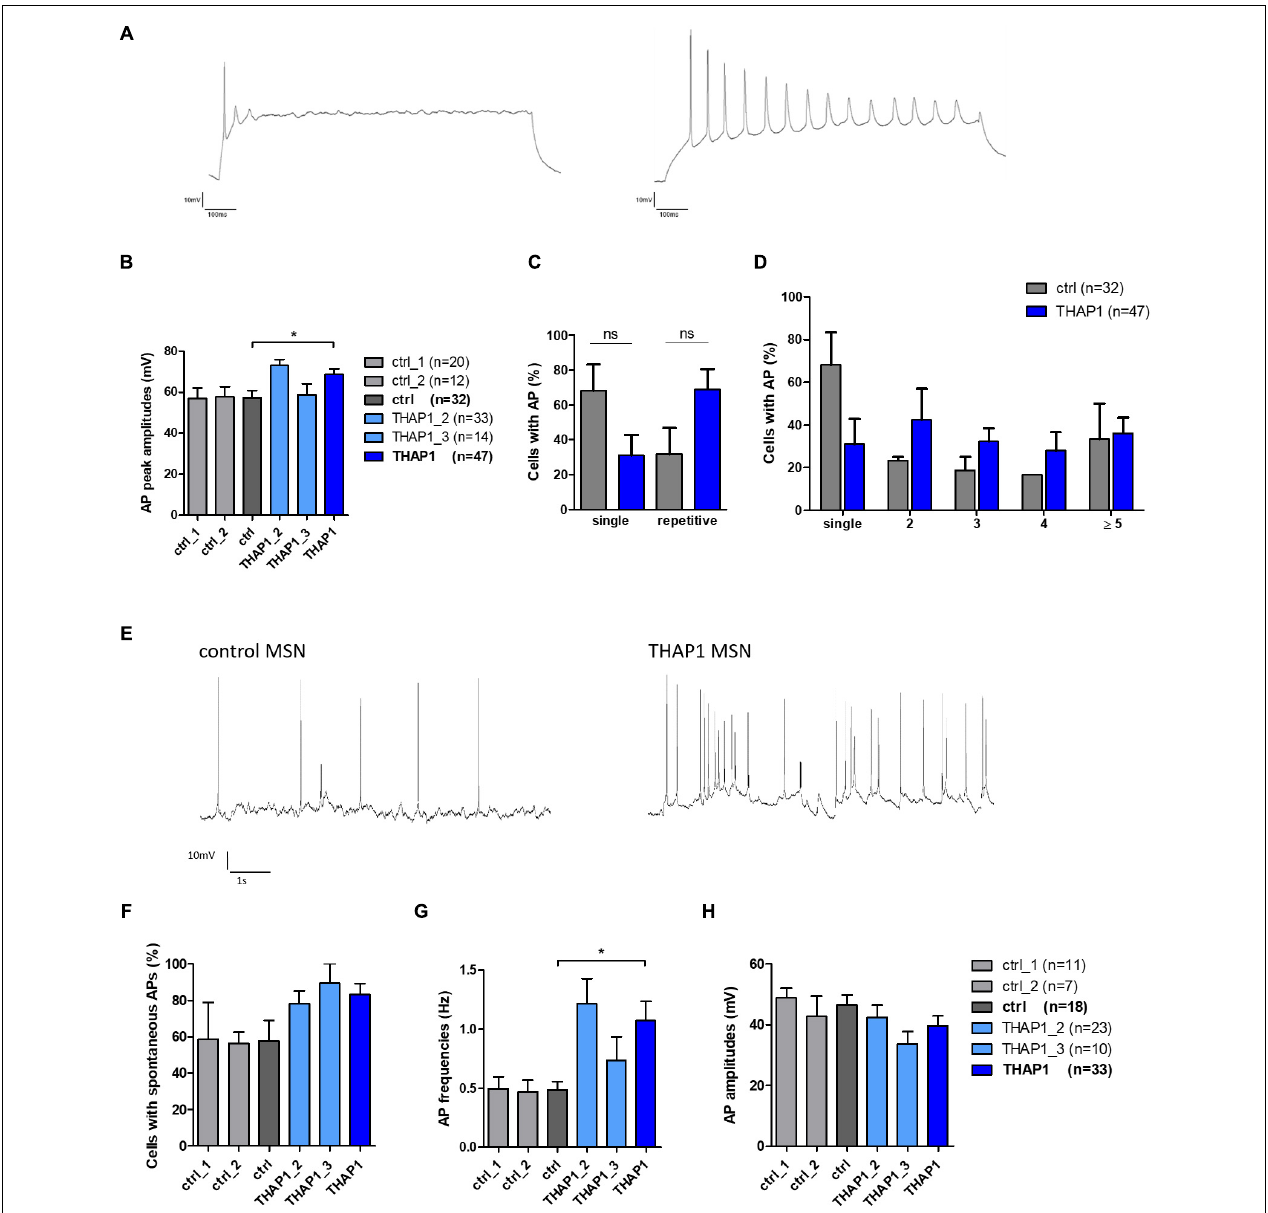
FIGURE 6 | Evoked and spontaneous action potentials (APs) of MSNs from DYT-THAP1 patients and healthy controls. (A) Example of THAP1 MSNs firing single and repetitive action potentials upon depolarization in current-clamp mode from a holding potential of approximately –70 mV. (B) Action potential peak amplitudes were significantly elevated in THAP1 ( n = 47) compared with control MSNs ( n = 32, * p < 0.05, unpaired t -test). (C) Percentages of neurons with single or repetitive action potentials were not significantly different between MSNs of both groups (non-parametric Mann-Whitney test). (D) Percentages of neurons with single or repetitive (2, 3, 4, ≥ 5) action potentials were not significantly different between MSNs of both groups although overall there was a tendency to more THAP1 neurons with repetitive APs (two-way ANOVA with Bonferroni post hoc test). (E) Spontaneous AP firing was measured at a holding potential of approximately –60 mV showing more APs in THAP1 than control MSN. (F) Percentage of cells with spontaneous APs was comparable for THAP1 and control MSNs. (G) Interestingly, frequencies of spontaneous APs were significantly elevated for THAP1 ( n = 33) compared with control MSNs ( n = 18, * p < 0.05, non-parametric Mann-Whitney test). (H) Amplitudes of spontaneous APs were similar for THAP1 and control MSNs. Abbreviation: ns, not significant. Data from two control lines and two THAP1 lines (THAP1_2, THAP1_3) from at least two independent differentiations were analyzed. Data are presented as means ±